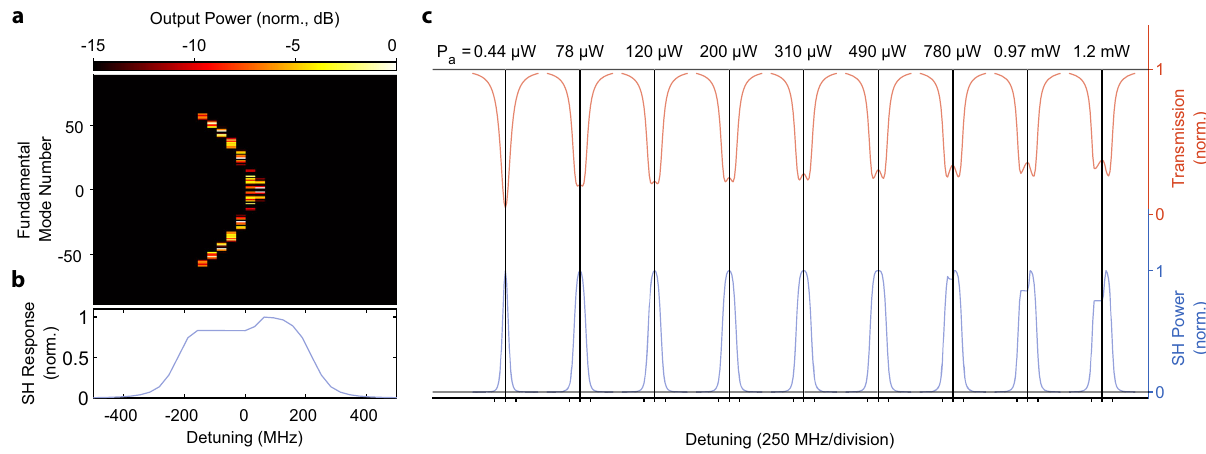
Fig. 6 Simulated effect of 0.1% disorder in the mode-to-mode loss rates on the cascaded OPO. a Cascaded OPO signal as a function of pump detuning, simulated at 0.97 mW of pump power. b Second Harmonic lineshape corresponding to the cascaded OPO in panel ( a ). c Lineshape evolution as a function of power, asymmetry is developed below 780 μ W, which agrees with the experiment.